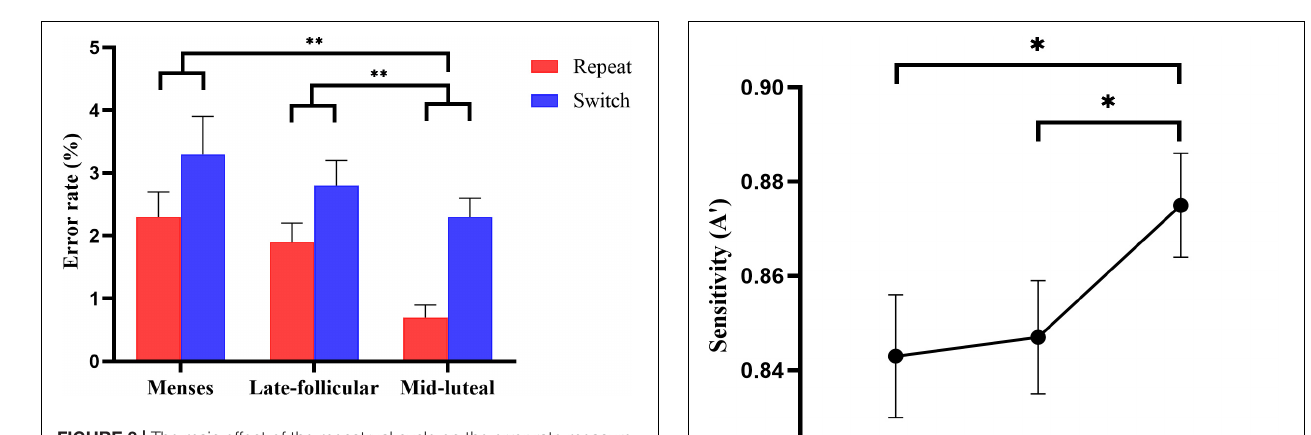
FIGURE 3 | The main effect of the menstrual cycle on the error rate measure of the task-switching task. Error bars represent the standard error of the mean. ∗∗ indicates p < 0.01.